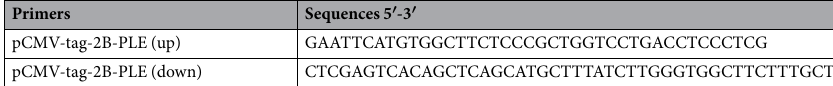
the quantification of AMO/AMP and their metabolites. Chromatographic separation was performed using a reverse-phase C18 polymeric column (ACQUITY UPLC BEH, 2.1 mm × 100 mm, 1.7 μ m). Gradient elu- tion was performed using a mobile phase of 0.1% formic acid in water (A) and acetonitrile (B) at a flow rate of 0.4 mL/min. The gradient elution used was as follows: 0–0.5 min, A-99%; 0.6–7.5 min, A-1%; 7.6–10 min, A-99%. The auto sampler was set at 6 °C and the column temperature was 45 °C. The scanned area λ was 190– 600 nm and covered almost all spectral ranges 8,9,49 . Conditions for the ESI source for positive ionization mode were optimized by direct infusion of standard solutions of AMO, AMP, AMA, DIKETO and APA (Toronto Research Chemicals). Capillary voltage was set to 2 kv, sampling cone was 30 v and source temperature was 120 °C. N 2 was used as the desolvation gas with 800 L/h at 450 °C, and Argon was used as the collision gas with 50 L/h. The collision energy was set to 6.0 ev and the scanning range was m/z = 100–1000. Data analysis was performed with MassLynx software Version 4.1. All quantifications were performed based on the peak areas. The calibration curves were constructed with